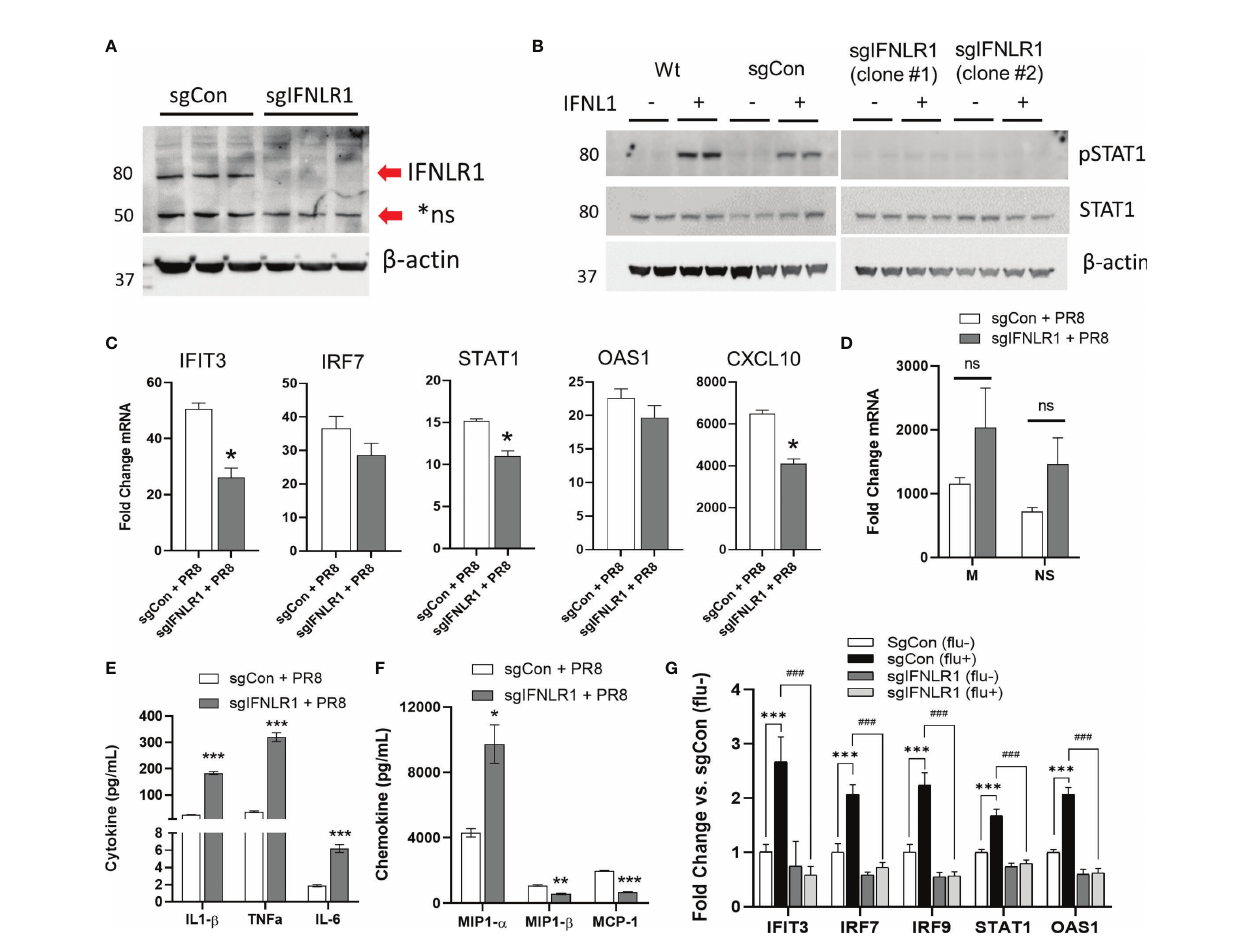
FIGURE 6 | Macrophage IFNLR1 is indispensible for anti-viral immunity. Control Cas9 THP-1 monocytes (sgCon) and IFNLR1-KO THP-1 monocytes (sgIFNLR1) were differentiated with PMA (20 ng/mL) for 7 days prior to harvest. IFNLR1 protein was measured via immunoblotting (A) . sgCon and sgIFNLR1 cells lines were differentiated as described above. At 30 minutes prior to harvest, cells were treated with 50 ng/mL IFNL1. Cells were harvested and total STAT1 and phosphorylated STAT1 induction (pSTAT1) was measured via immunoblotting (B) . Representative of 2 independent experiments (A, B) . sgCon and sgIFNLR1 were differentiated as above followed by PR8 infection (MOI=0.01) for 24 h. We then measured fold change in ISGs by qRT-PCR. *p < 0.05 vs. sgCon + PR8 by Students T-test (C) , fold change in viral mRNA (M gene and NS gene) vs. uninfected (D) , and secreted in fl ammatory cytokines/chemokines in in fl uenza infected macrophages using a custom multiplex from MSD. ns, not signi fi cant. *p < 0.05, **p < 0.01, ***p < 0.001 vs. sgCon + PR8 by Multiple T-test with Holm-Sidak correction (E, F) . representative of 3 independent experiment, n= 3 (C – F) . sgCon and sgIFNLR1 THP-1 were differentiated with PMA and treated with supernatants (culture medium) collected from human airway epithelia previously infected with ( fl u+) or without in fl uenza ( fl u-) (CA09, MOI=1) ***p < 0.001 vs. sgCon ( fl u-); ### p < 0.001 vs. sgCon ( fl u+) by Multiple T-test with Holm-Sidak correction (G)